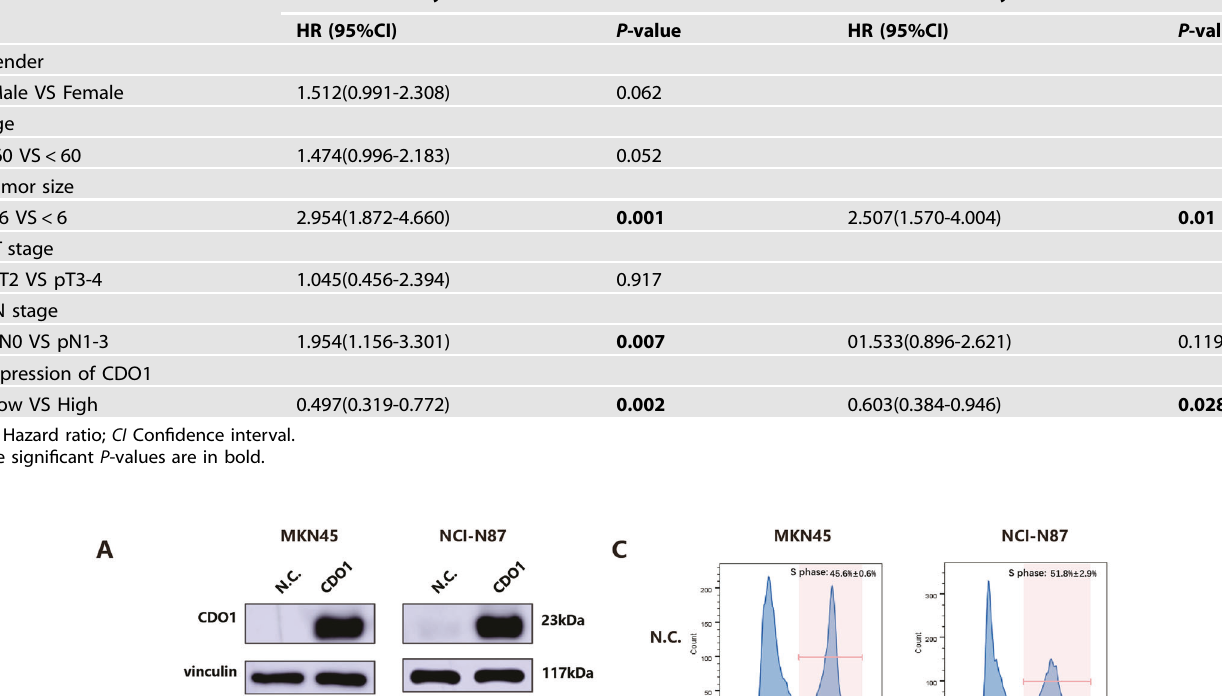
Table 3. Univariate/multivariate analysis of CDO1 expression in the outcome of patients with GC. Characteristics